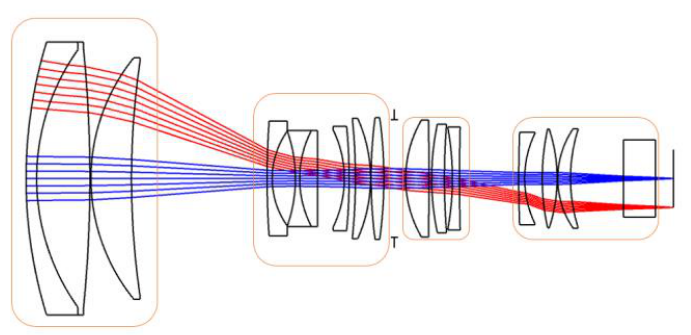
Figure 4. Light path diagram of initial layout [16].